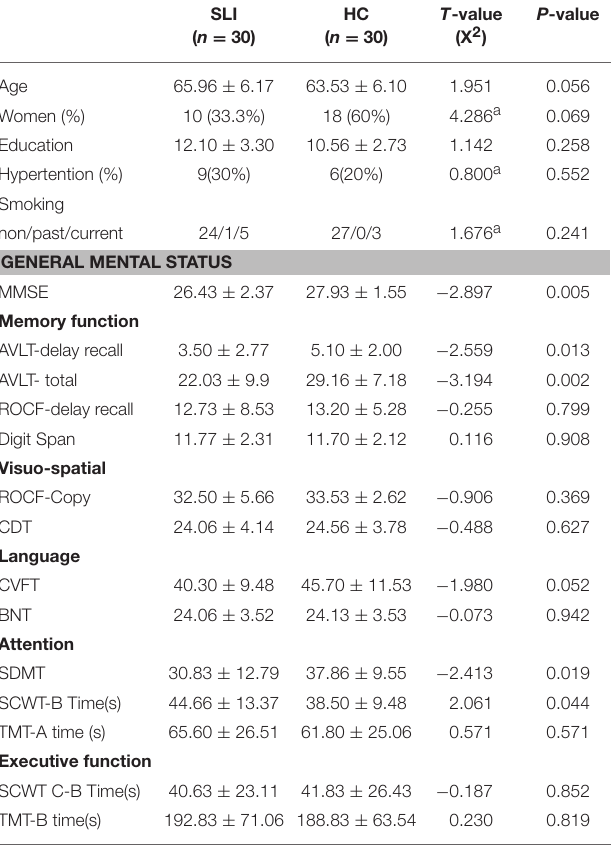
TABLE 1 | Demographic and neuropsychological